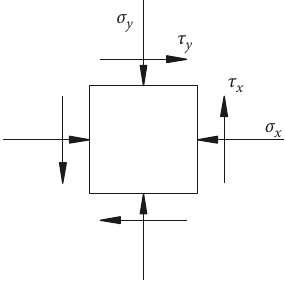
Figure 17: Model of the interposed layer cell.